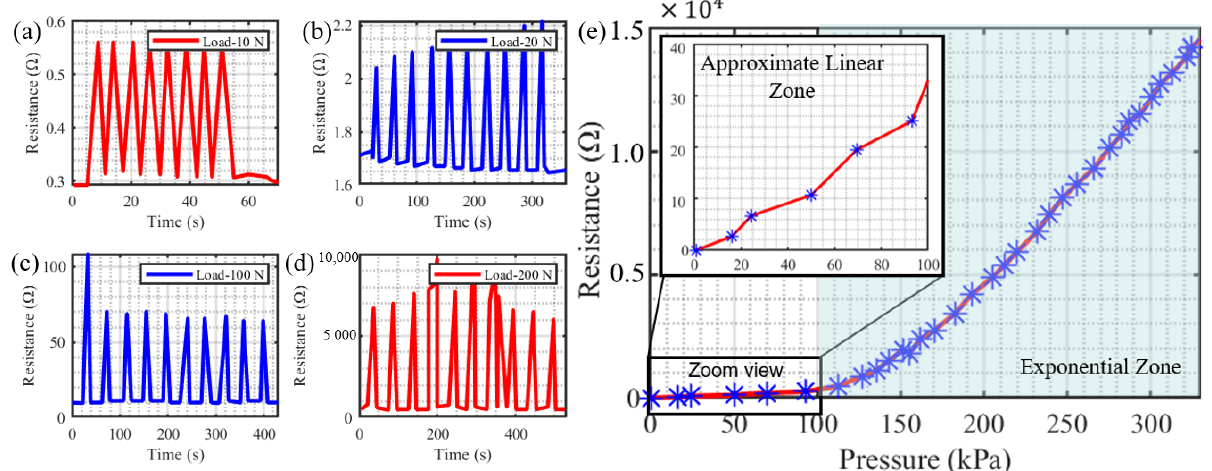
Figure 10. ( a – d ) indicate the working stability test curve: under–over 10 cycles for loads of 10 N, 20 N, 100 N, and 200 N respectively, the output signals exhibit excellent repeatability and stability; ( e ) refers to the calibration curve to describe the relationship between the resistance value and the pressure applied, and the measurement range is divided into two zones: approximate linear sensitivity zone (0–100 kPa) and exponential sensitivity zone (over 100